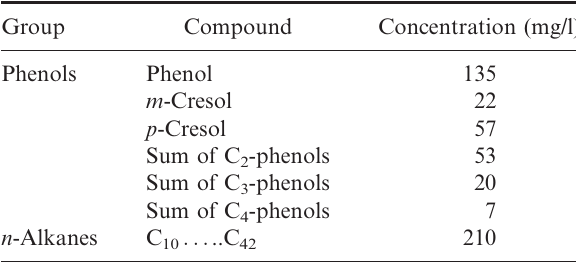
Table 5. Analytically detectable main monomeric com- pounds of the water of the disposal pond at a depth of 24 m (Wießner et al.